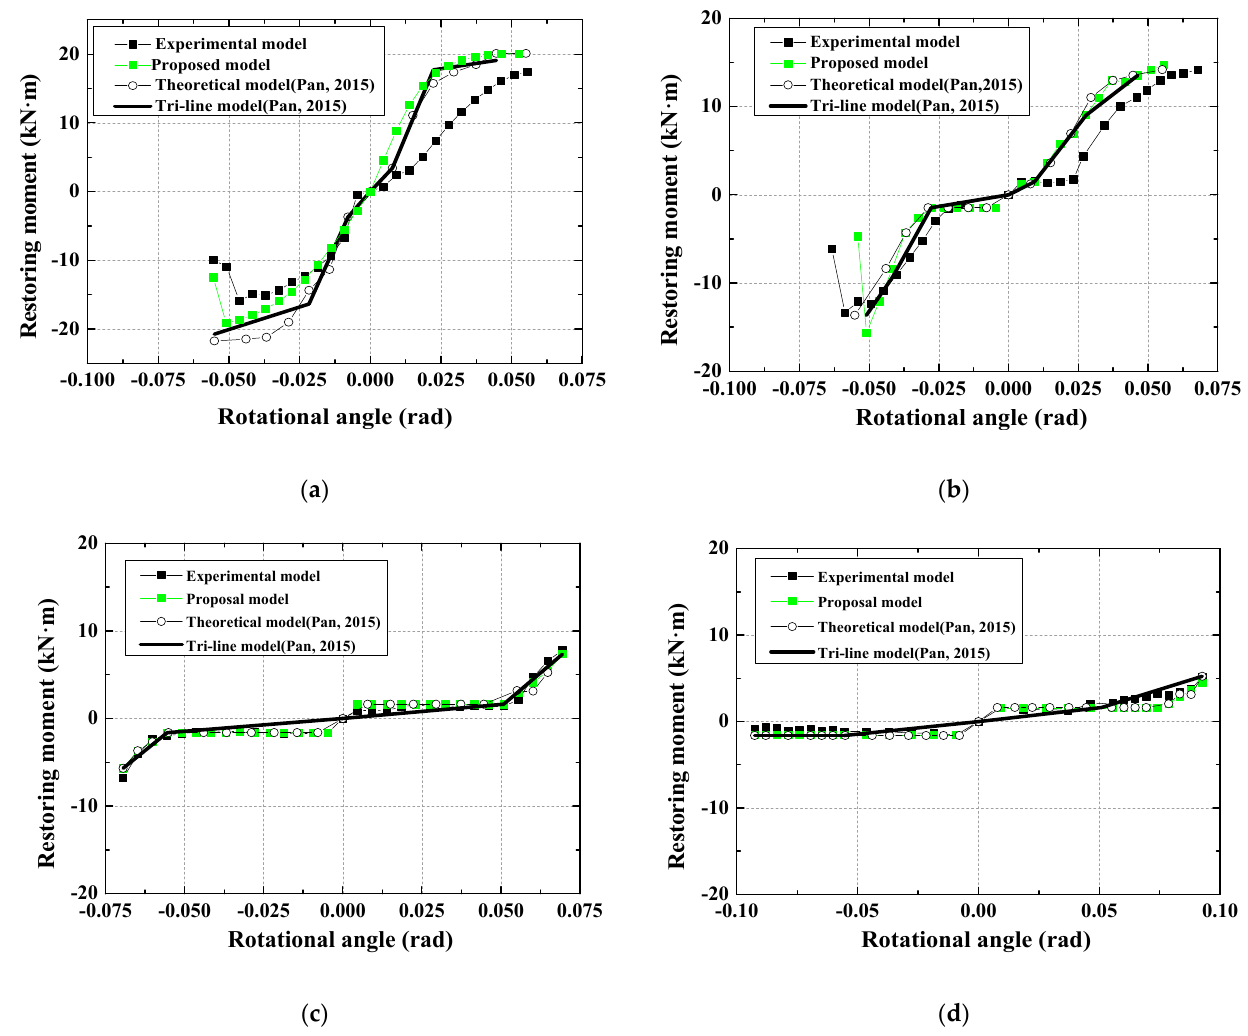
Figure 27. Curves of restoring moment and rotational angle. ( a ) LJ-1. ( b ) LJ-2. ( c ) LJ-3. ( d ) LJ-4.